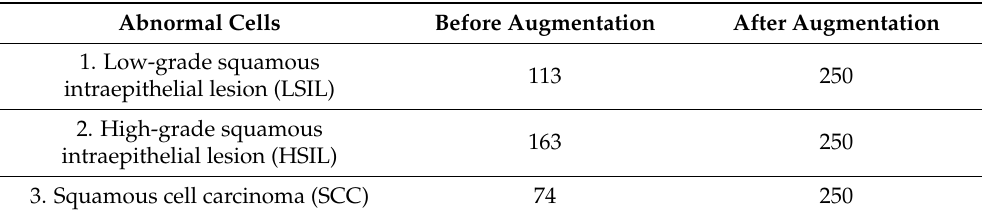
Table 1. The number of images before and after augmentation for abnormal cells. After augmentation the number of images becomes